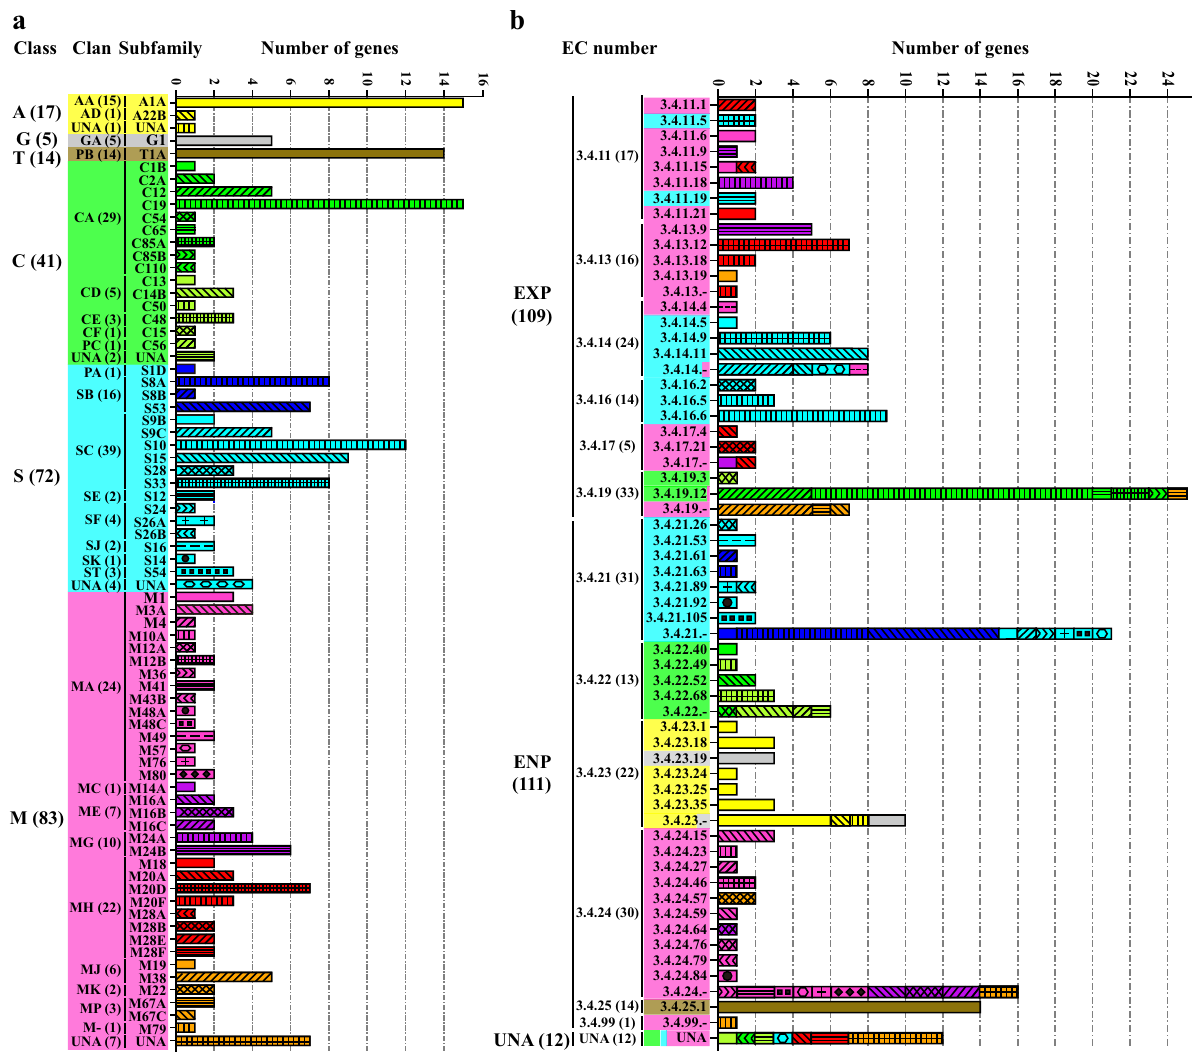
Figure 1. Reclassification of the putative proteases from A. niger CBS 513.88 and ATCC 1015. ( a ) Assignment of the proteases according to their substrate specificities, cleavage sites and active sites. ( b ) Classification of the proteases based on their EC numbers; proteases in Fig. 1b are highlighted with the same color and the same types of columns as the corresponding members in Fig. 1a; UNA, unassigned, peptidases that can’t be assigned into any clan or family; EXP, exopeptidases; ENP, endopeptidases; figures in parentheses indicate the number of proteases in each clan or